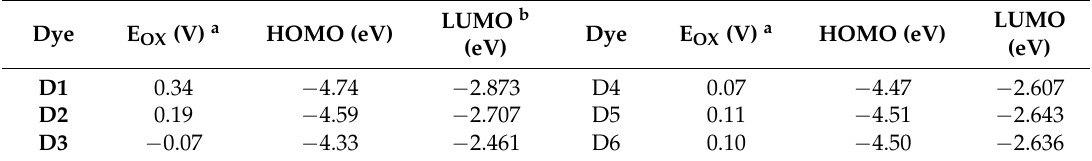
Table 4. Electrochemical properties of the six natural dyes.